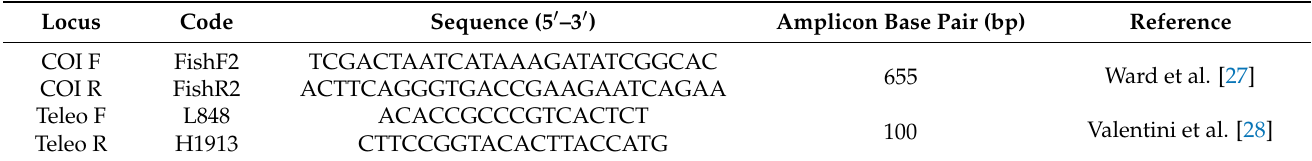
Table 2. Primer sets that were used for tuna species identification assessed in this